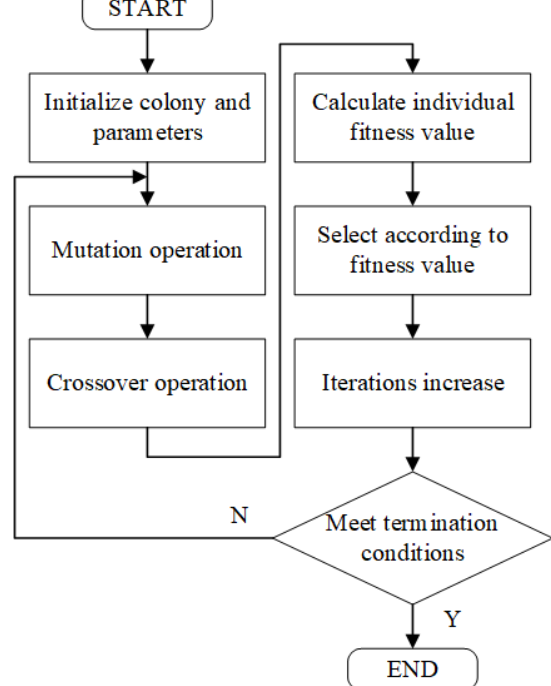
Figure 8. Flow chart of the differential evolution algorithm.